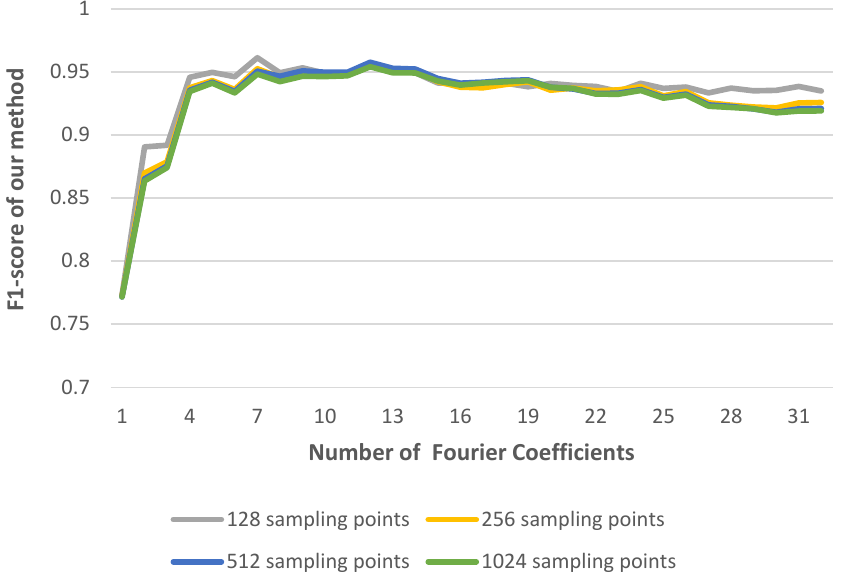
Figure 14. F1-score of our method under different value of parameters.